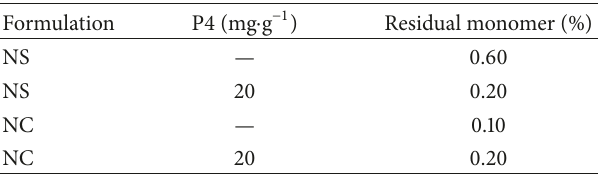
Table 8: Residual monomer content obtained by gas chromatogra- phy at the end of the reactions ( t = 280